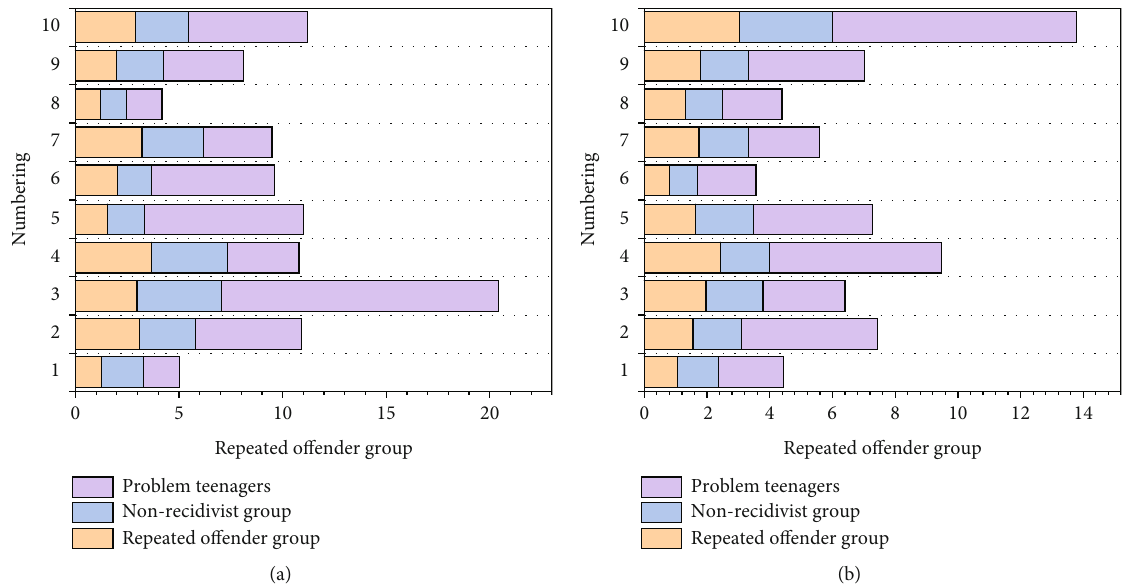
Figure 6: OR values of di ff erent groups of adolescents compared with normal youths in the HOS and SOC scales ((a) OR values in the HOS scale and (b) OR values in the SOC scale).